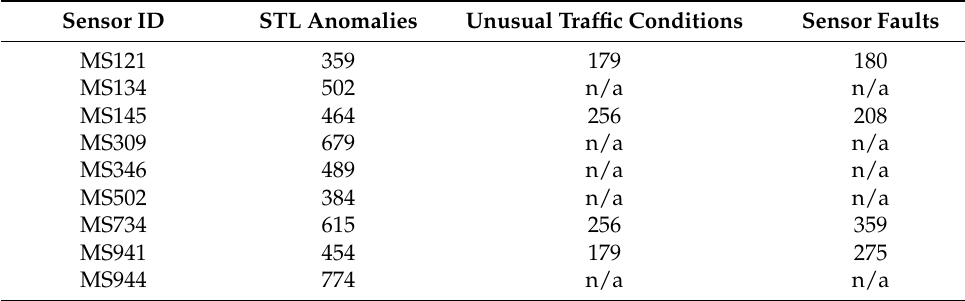
Table 4. Anomalies detected by the STL